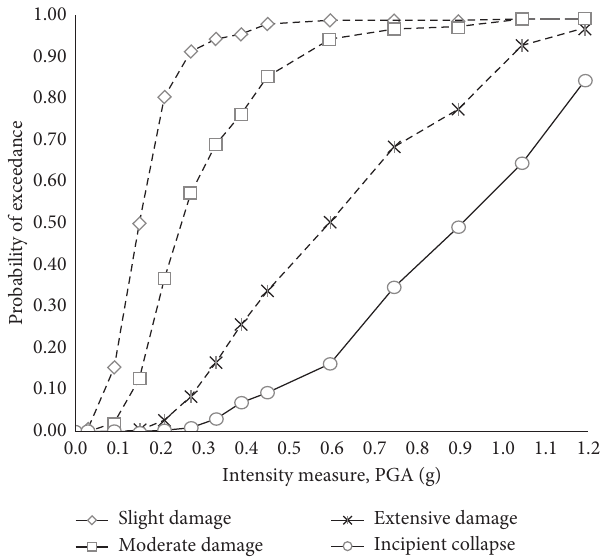
Figure 16: Fragility function development for the frame typology of Pakistan.